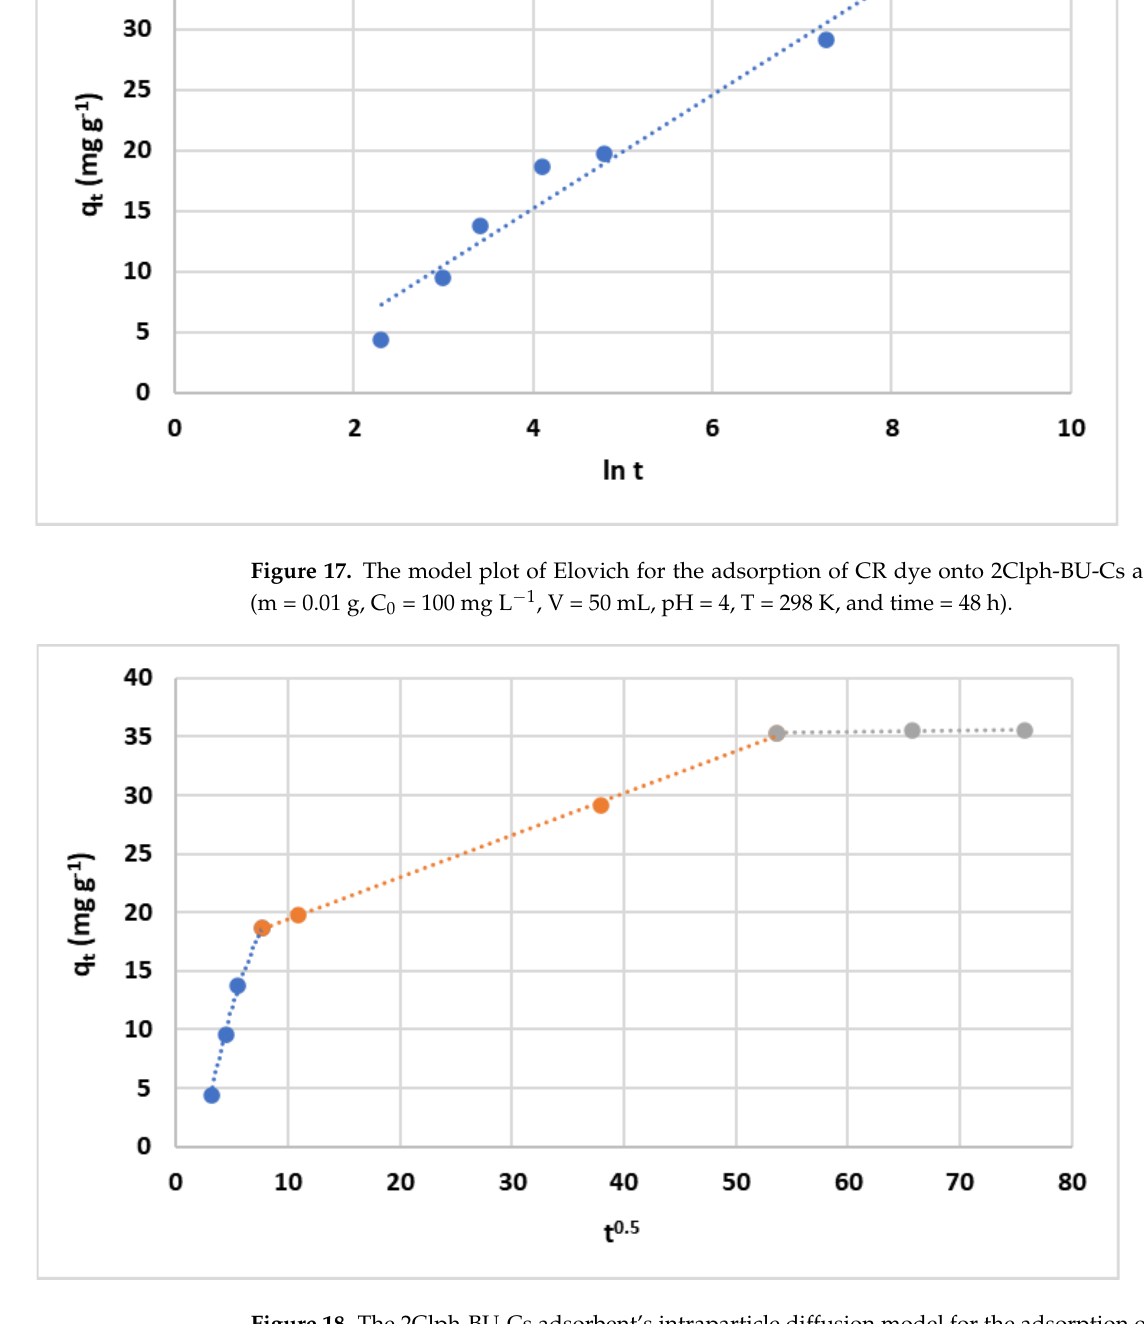
Figure 18. The 2Clph-BU-Cs adsorbent’s intraparticle diffusion model for the adsorption of CR dye (m = 0.01 g, C 0 = 100 mg L −1 , V = 50 mL, pH = 4, T = 298 K, and time = 48 h).